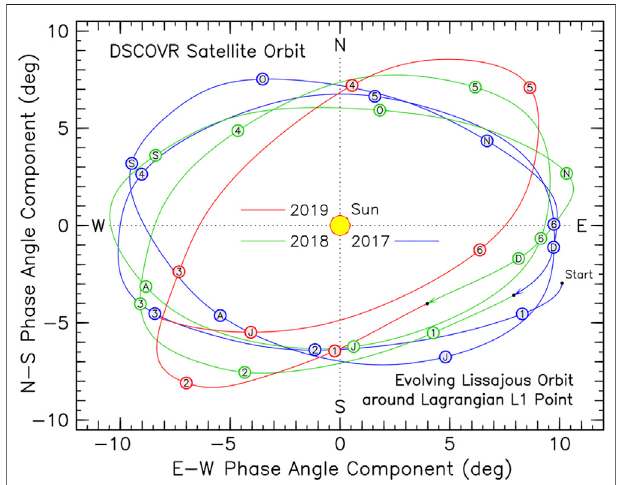
FIGURE 2 | The phase angle (also Sun-Earth-Satellite angle, or 180 ° — scattering angle) de fi nes the angular separation between the DSCOVR Satellite and the Sun, as viewed from the Earth. The color-coded sky-map traces its evolving Lissajous orbital path around the Lagrange L1 point starting from 1 January 2017 (blue) to 27 June 2019 (red). The directions N S, and W E, represent the Satellite displacement relative to the Sun. Circles depict the mid-month orbital positions with the numbers 1 to 6 representing months January to June of the fi rst orbit of the year, and the letters J to D standing for July to December of the second orbit of the